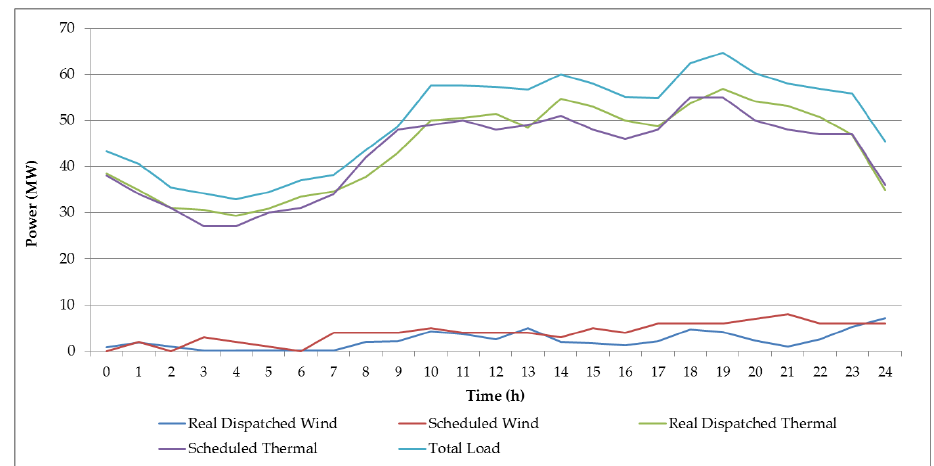
Figure 7. Comparison results between real dispatched and proposed scheduled.